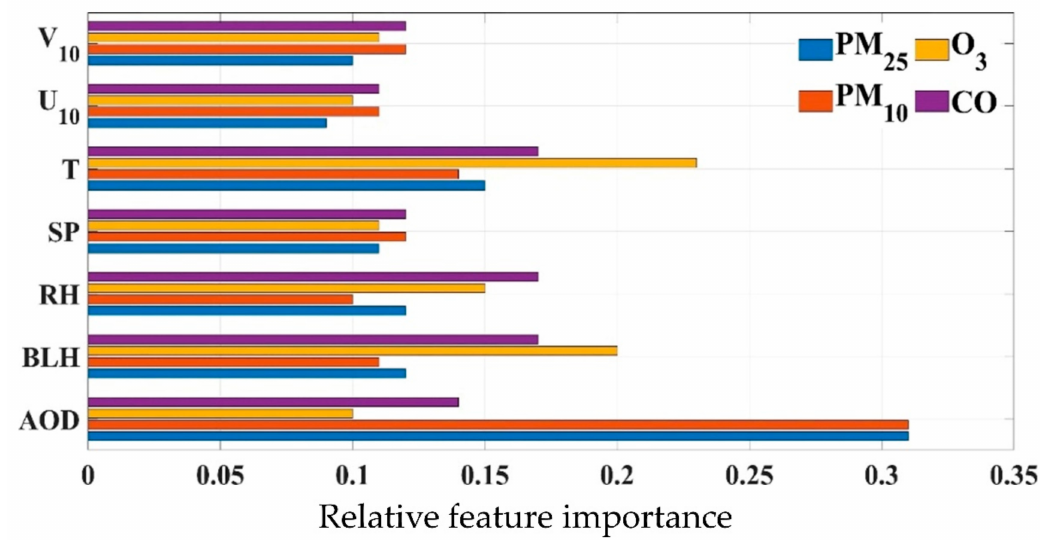
Figure 4. Relative feature importance of the predictors in geographical RF model simulations.